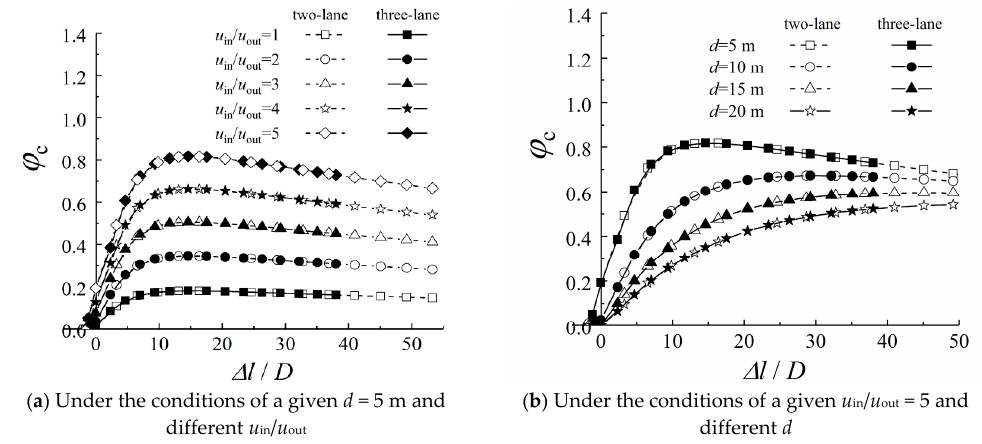
Figure 13. Impacts of ∆ l / D on circulating air mixing ratio φ c.